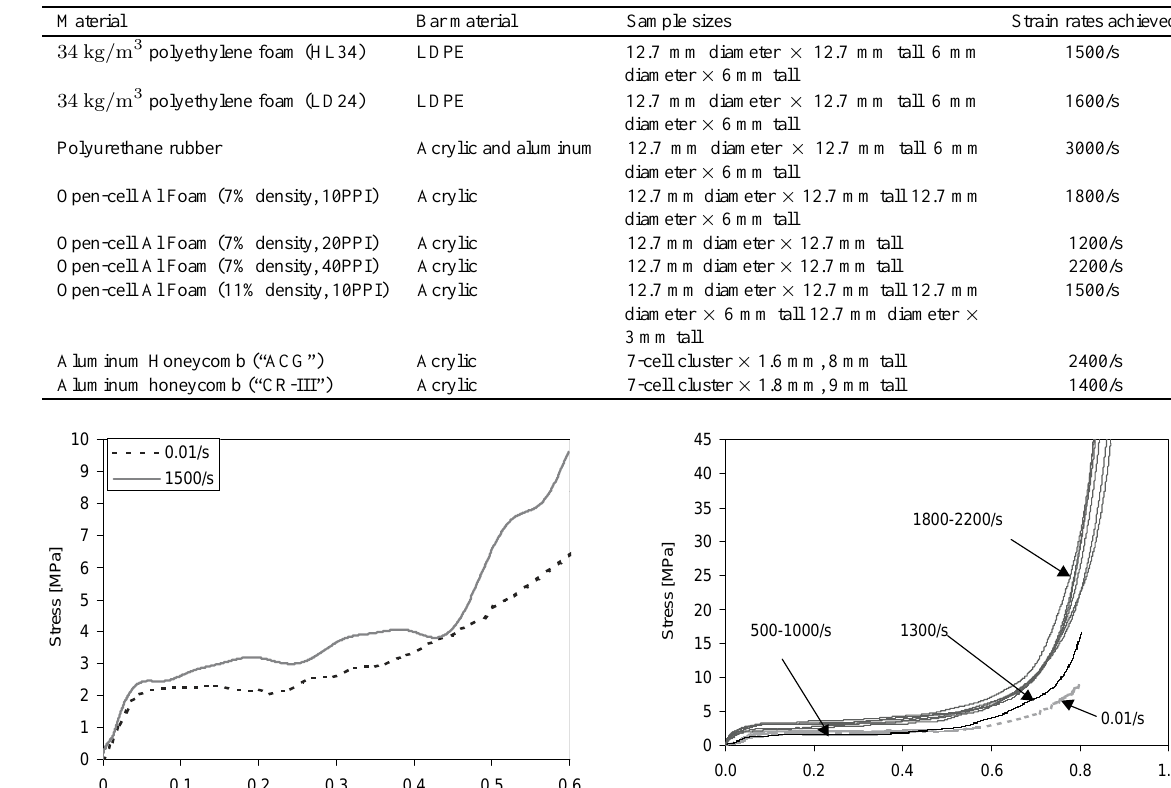
Table 2 Sample sizes, Hopkinson bars used, and achieved strain rates for high-rate material tests